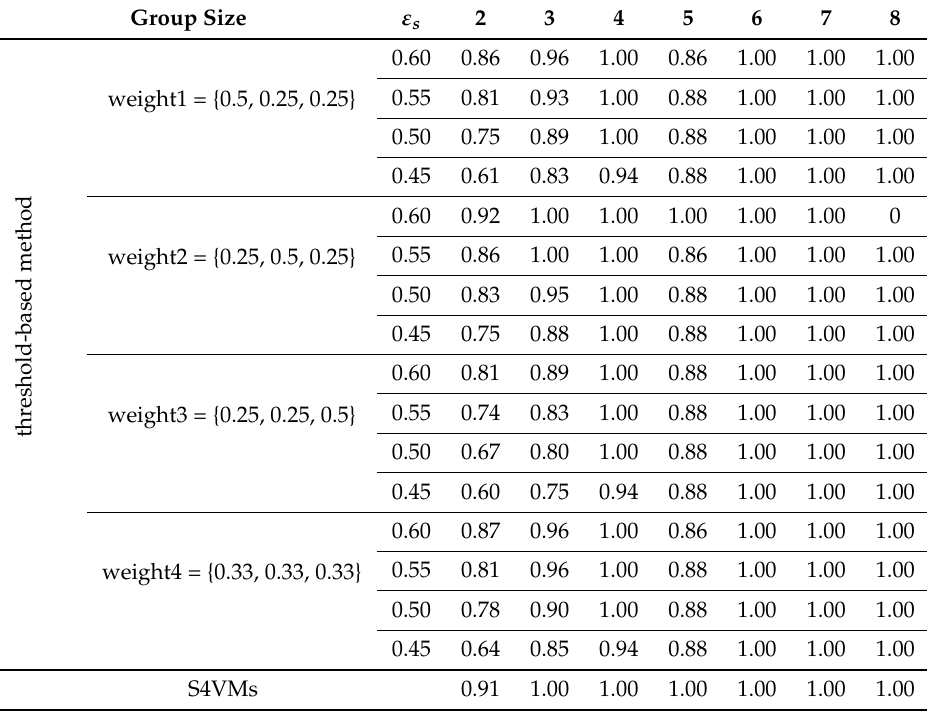
Table 4. Matching ratio of the transportation mode Group